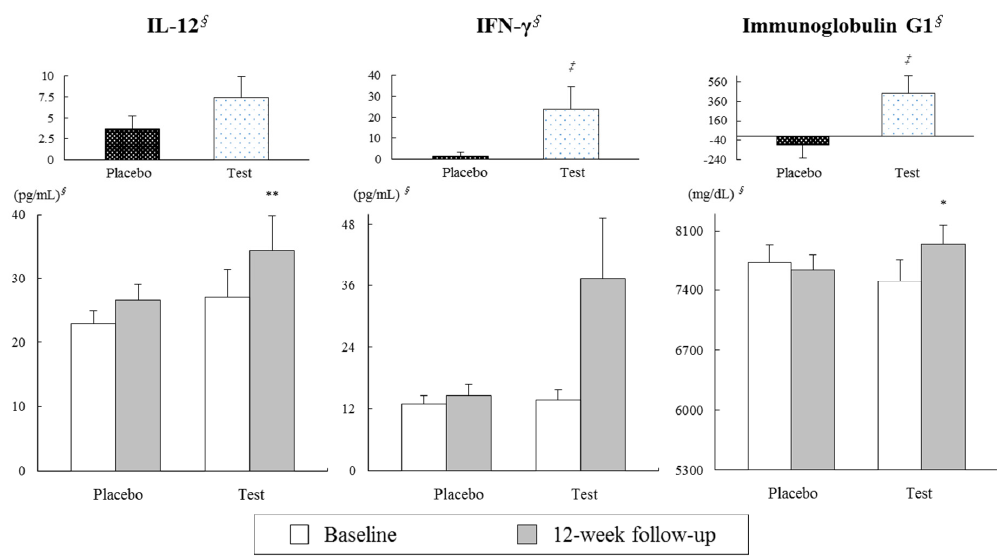
Figure 1. Effects on serum interleukin (IL) ‐ 12, interferon (IFN) ‐γ , and immunoglobulin G1 concentrations following 12 weeks of consuming dairy yogurt containing L. paracasei , B. lactis and heat ‐ treated L. plantarum . Mean ± SE. ∮ tested by logarithmic transformation. * p < 0.05 and ** p < 0.01 derived from paired t ‐ tests within each group. ‡ p < 0.05 derived from independent t ‐ tests at changed value and adjusted for baseline values, sex, and changes in diastolic blood pressure (BP).